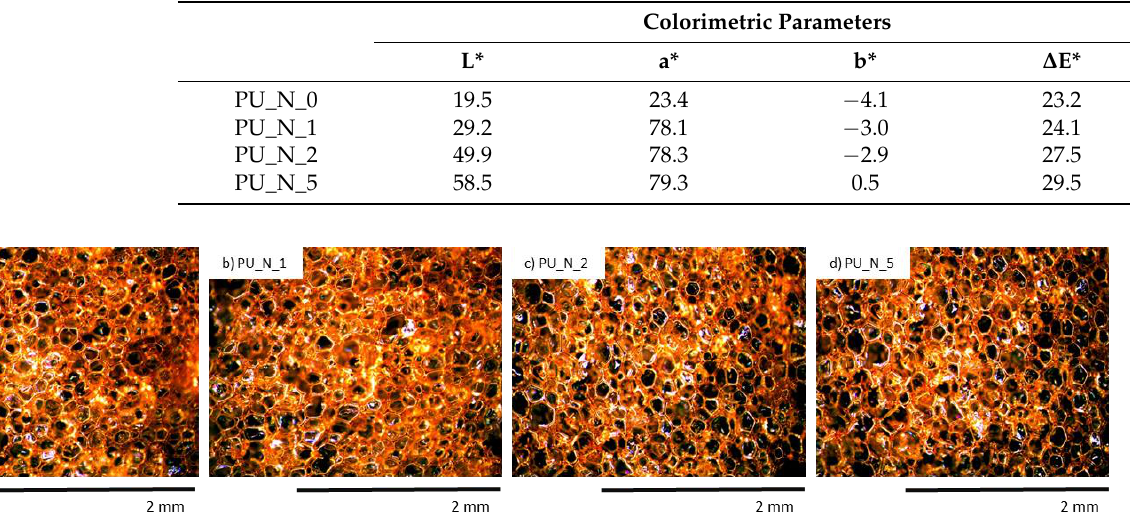
Figure 8. Morphology of PUR composite foams after 7 days of UV aging. Adapted from Ref. [10].